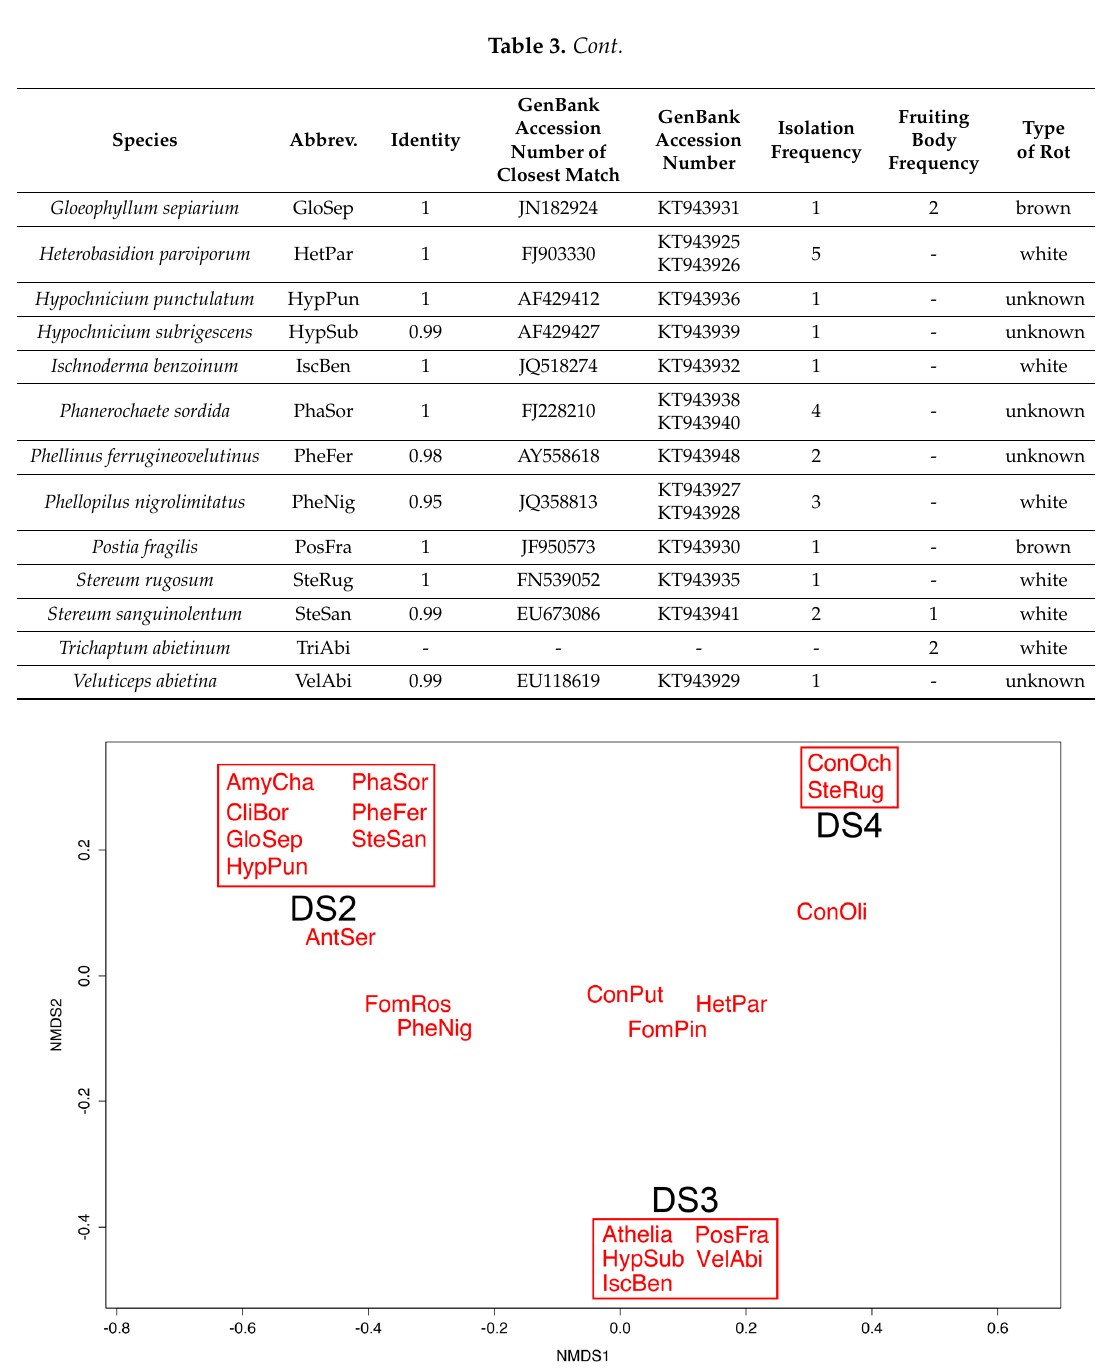
Figure 3. Non-metric multidimensional scaling of the different fungal species in relation to the decay stage (DS) of the stems. Species within boxes were solely associated with the corresponding decay stage. Increment-boring-core data only. See Table 3 for abbreviations of fungal species names.